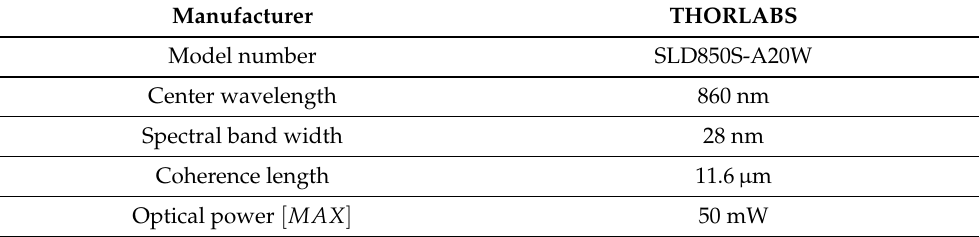
Table 1. SLD specification of